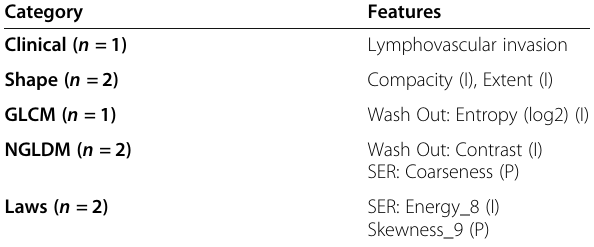
Table 1 Features chosen by CR pipeline. Features from intratumoral region are denoted by (I) and features from 4 mm peritumoral region are denoted by (P). There was only one clinical feature selected, and the remainder were radiomic features (5 from intratumoral region, 2 from peritumoral region) Category